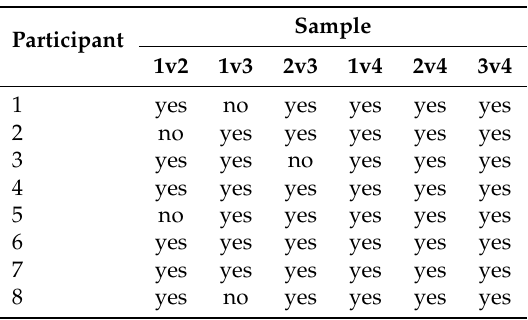
Table 4. Could the participant tell the difference between samples of the sensory